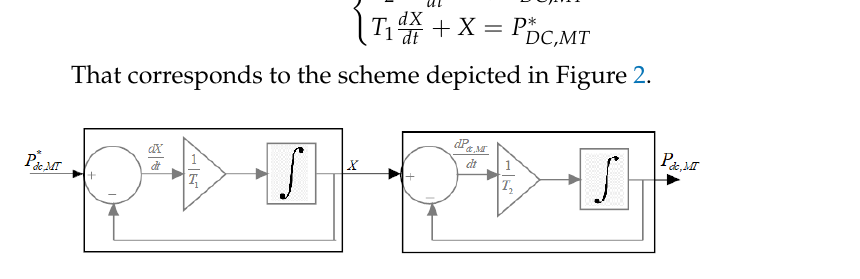
Figure 2. MT dynamic